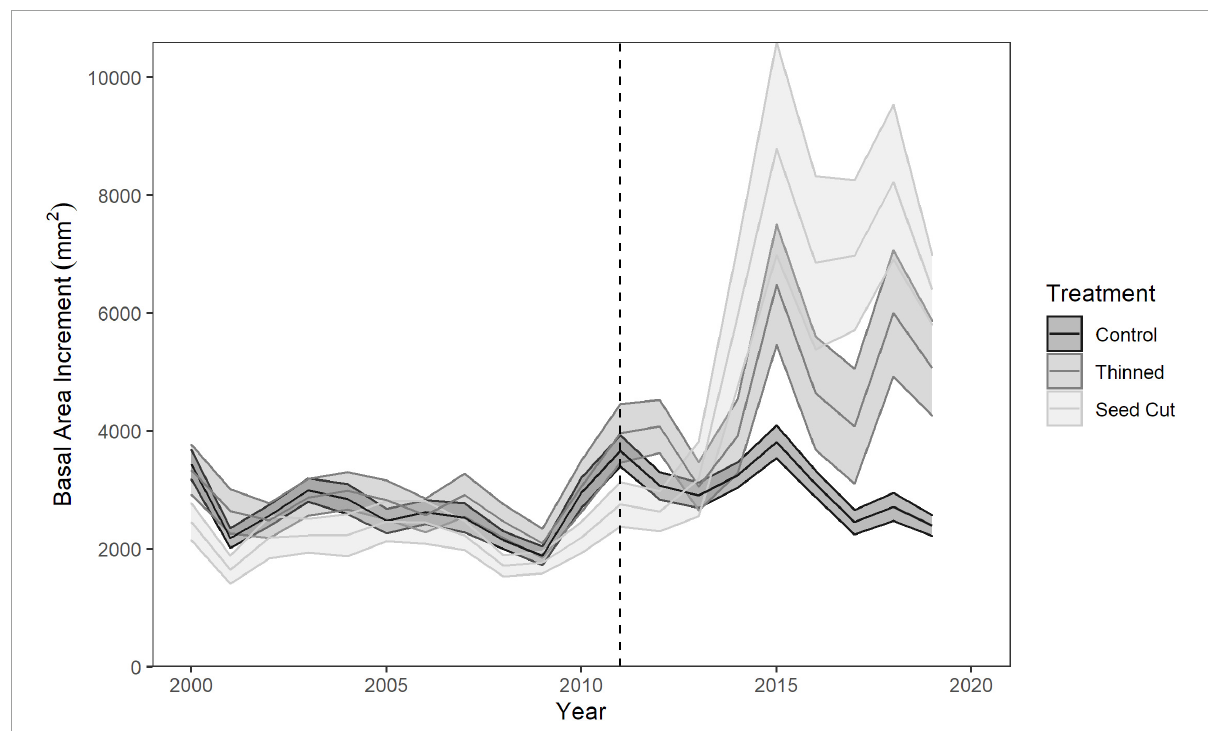
FIGURE6 Growth measured as mean basal area increment (BAI) of trees in each stand for the approximate decades before and after thinning prescriptions were implemented (2011, dashed line). Bands represent the standard error for each stand (number of samples are Control = 12, Thinned = 6, Seed Cut =